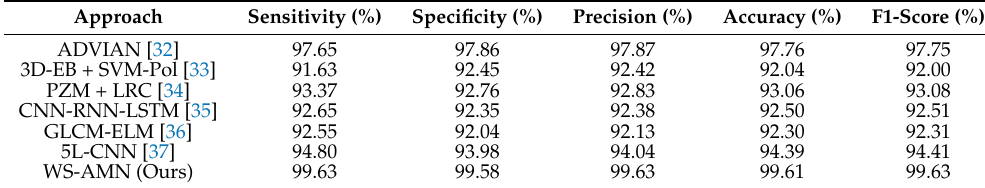
Table 6. Comparison with SOTA